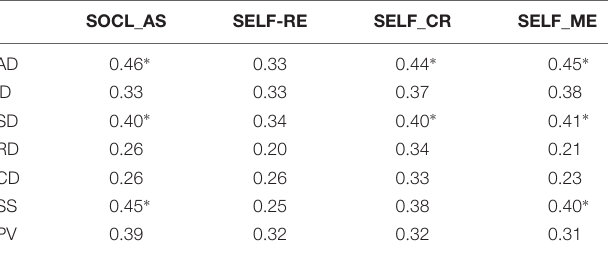
TABLE 6 | Correlations among subscales of types of internal dialogues (IDAS) and self-talk